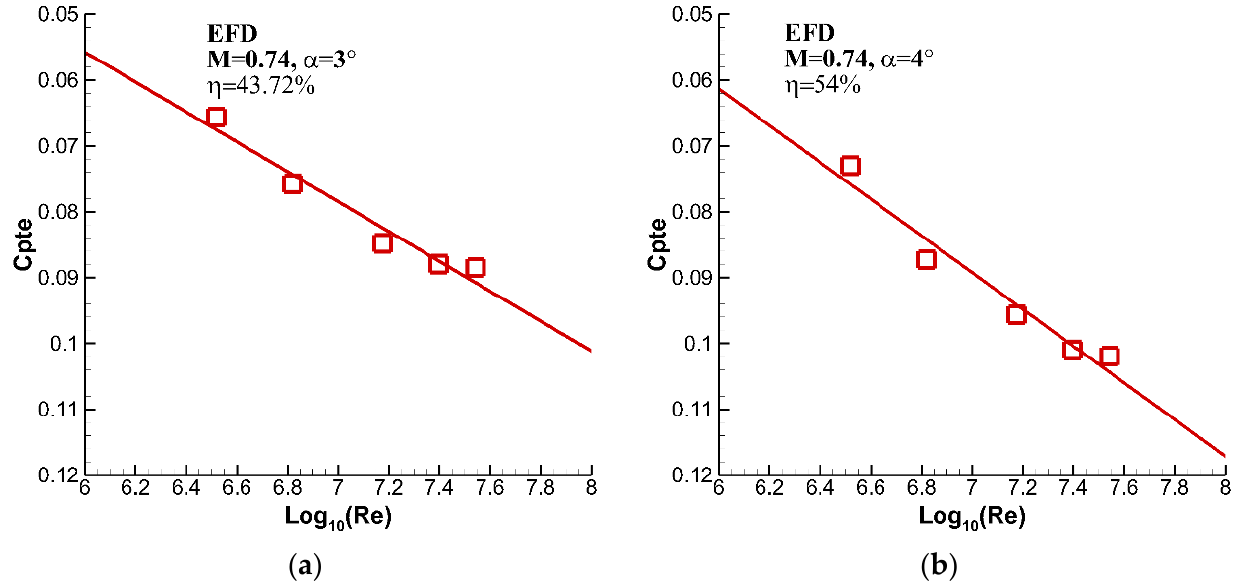
Figure 16. Reynolds number effect on trailing edge pressure recovery (M = 0.74): ( a ) α = 3°, η = 43.72%; ( b ) α = 4°, η = 54%.